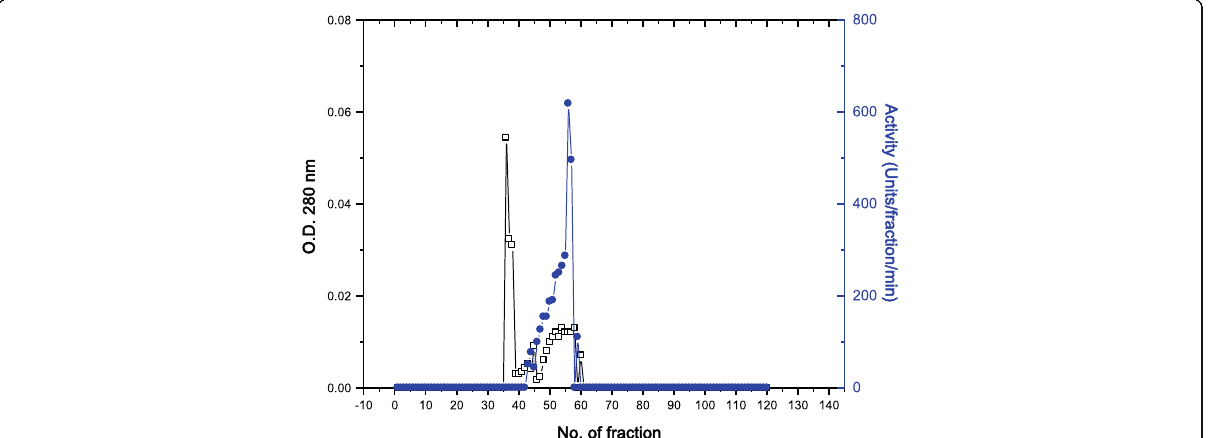
Fig. 3 A typical elution profile for the chromatography of GPII CM-Sepharose fraction on a Sephacryl S-200 column (90 × 1.6 cm i.d.) previously equilibrated with 50 mM sodium acetate buffer, pH 5.5, at a flow rate of 20 ml/h and 3 ml